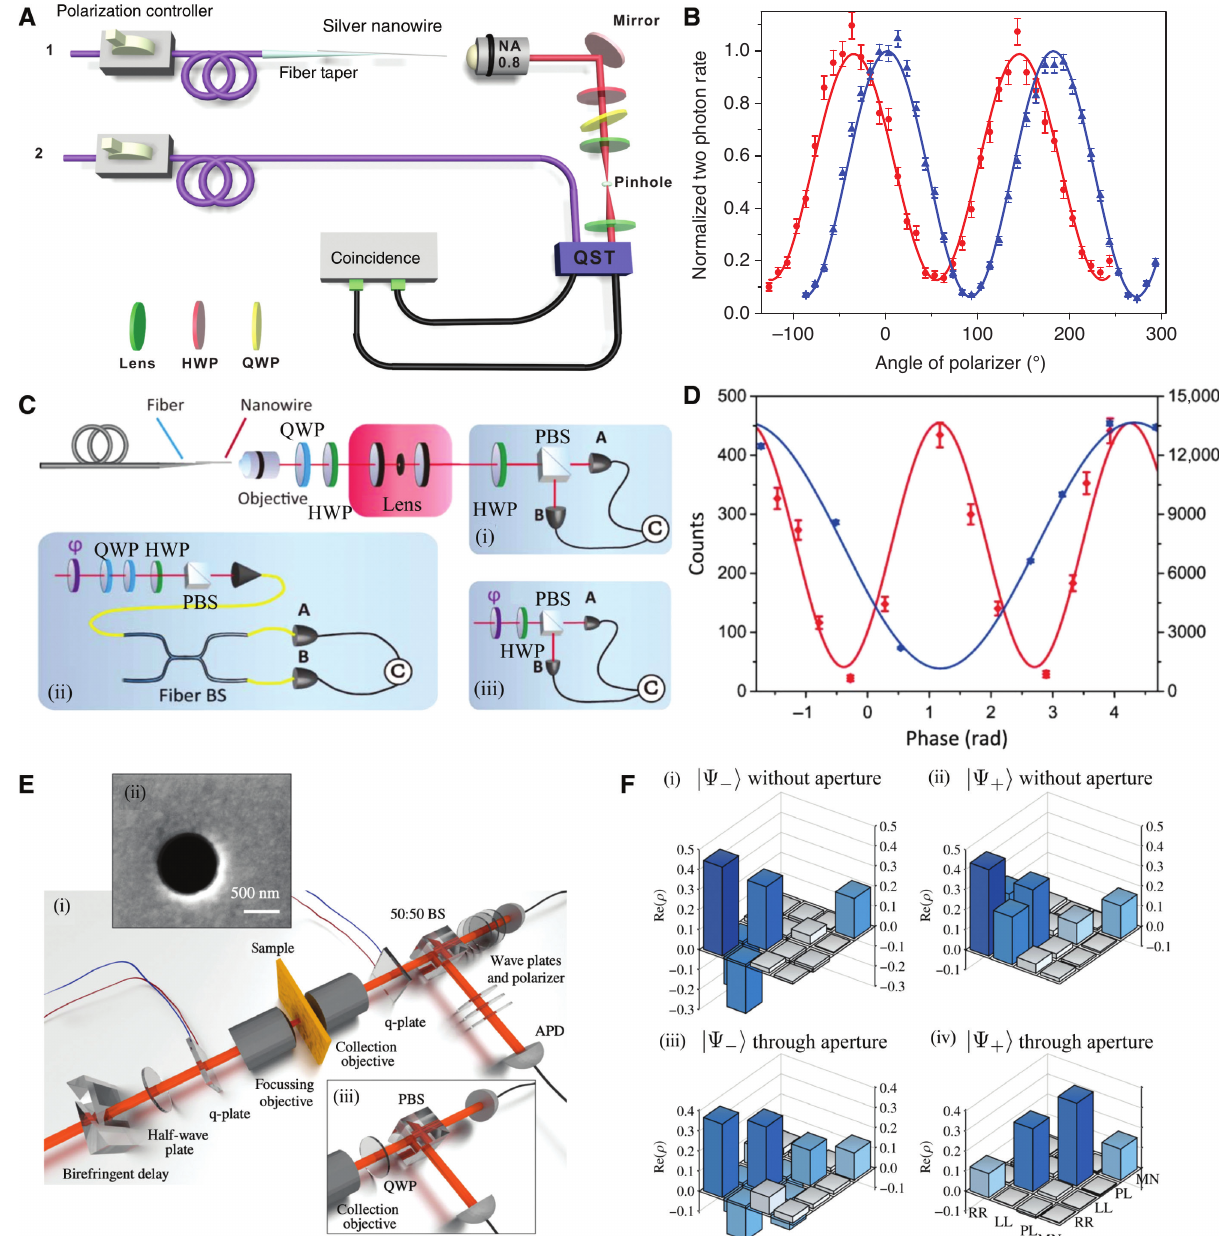
Figure 9: Experiments that demonstrate the preservation of entanglement in plasmonic systems. (A) Experimental setup used for polarization entanglement in a nanoscale hybrid plasmonic waveguide. In this case, one of the correlated photon pairs is sent to a silver nanowire, whereas the other photon partner is sent to a module for structures state tomography (QST). (B) Quantum interference structures observed through correlation measurements demonstrate the preservation of entanglement. Blue and red dots represent coincidence rates for photons projected onto different polarization states. (A and B) Reproduced from Ref. [178]. (C) Experimental setup for the demonstration of quantum plasmonic N00N states in a silver nanowire. The generated N00N state is transmitted and preserved in the nanowire. The transmitted photons are then forced to interfere in an HOM setup (ii). The arrangement used to measure the de Broglie wavelength of biphotons (iii). The transmitted two-photon entangled state is characterized by quantum state tomography (ii). (D) Two-photon coincidence counts and single-photon counts of the plasmonic N00N state transmitted in (C). The red curve represents the two-photon coincidence, whereas the blue curve represents single-photon counts. (C and D) Reproduced from Ref. [179]. (E) Schematic of the experimental setup for the symmetry protection of entanglement in a single nanoaperture. (F) Quantum tomography of the state | Ψ ⟩ and | Ψ ⟩ with and without the nanoaperture interaction. (E and F) Reproduced from Ref. + −